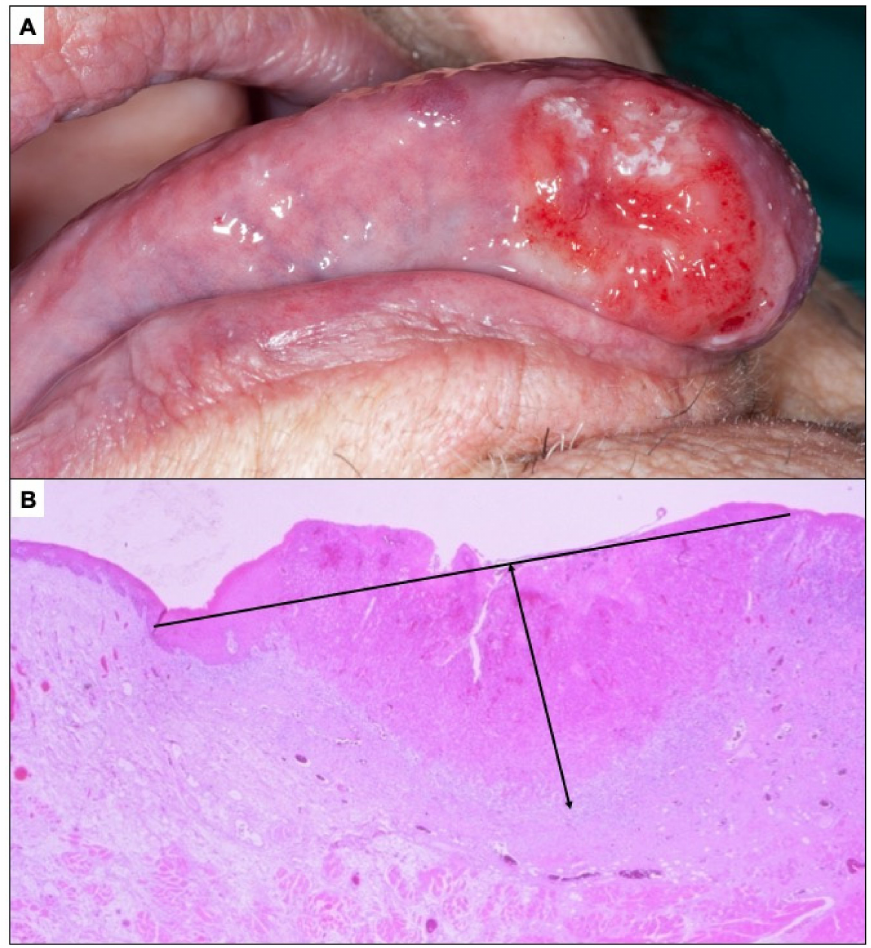
Figure 8. ( A ). Oral carcinoma less than 2 cm in greatest diameter whose classification as an incipient carcinoma is questionable. ( B ). Oral carcinoma less than 5 mm depth of